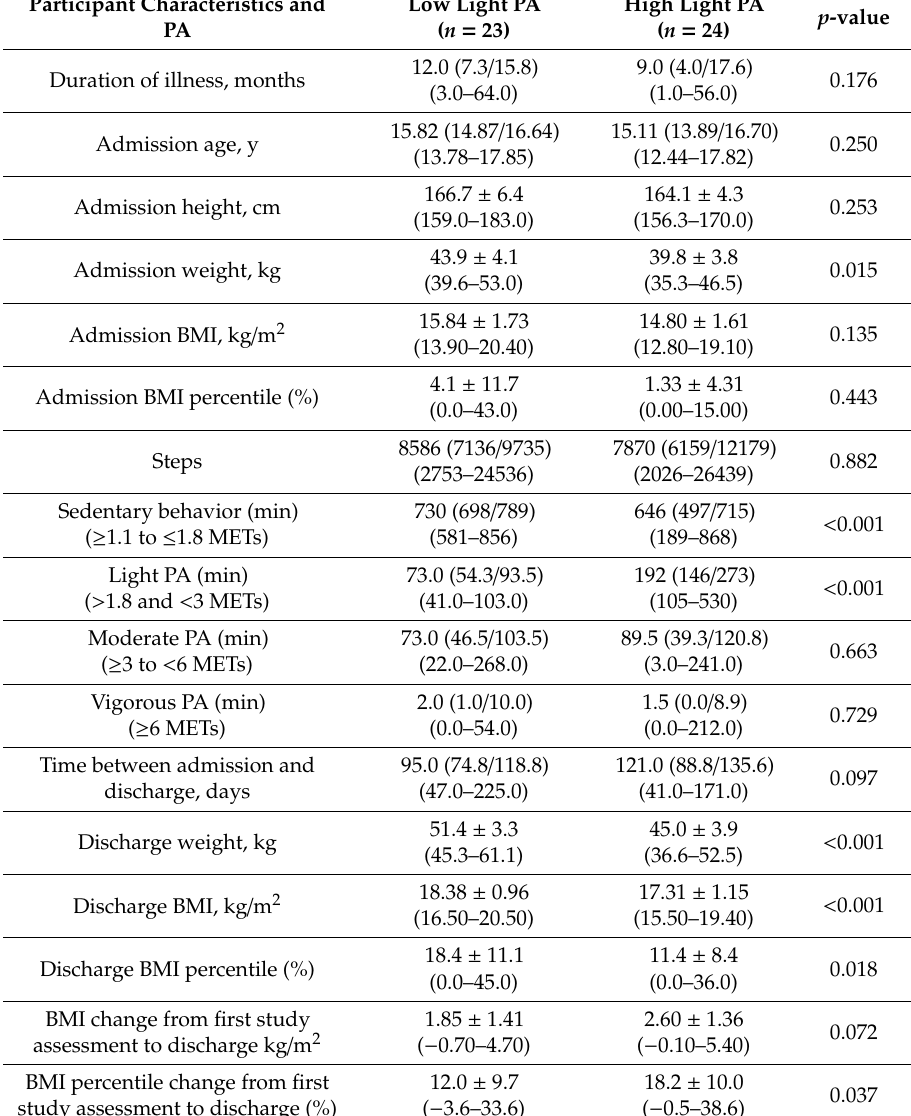
Table A1. General characteristics and PA parameters of AN patients at admission, first study assessment and discharge grouped by a low / high level of light PA (median